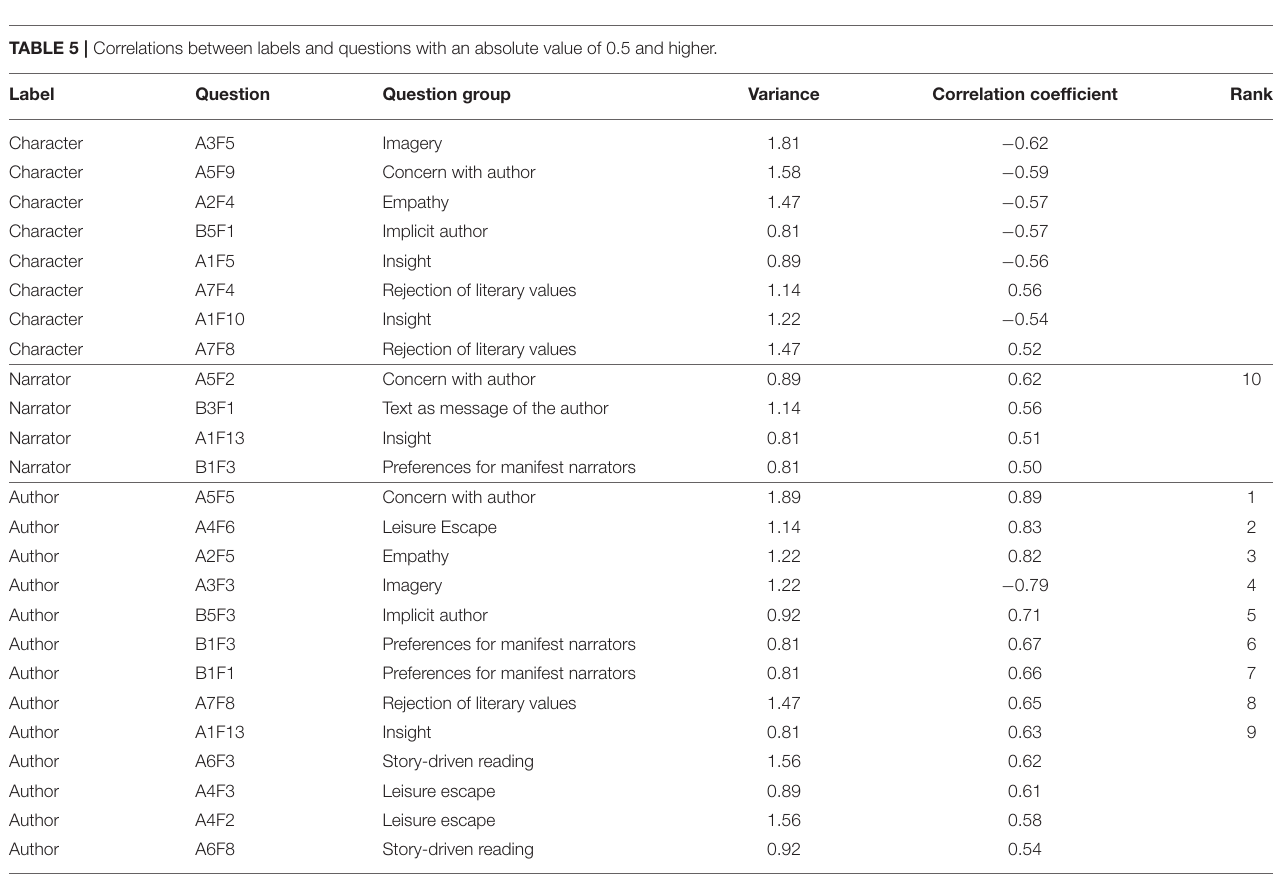
TABLE 5 | Correlations between labels and questions with an absolute value of 0.5 and higher.